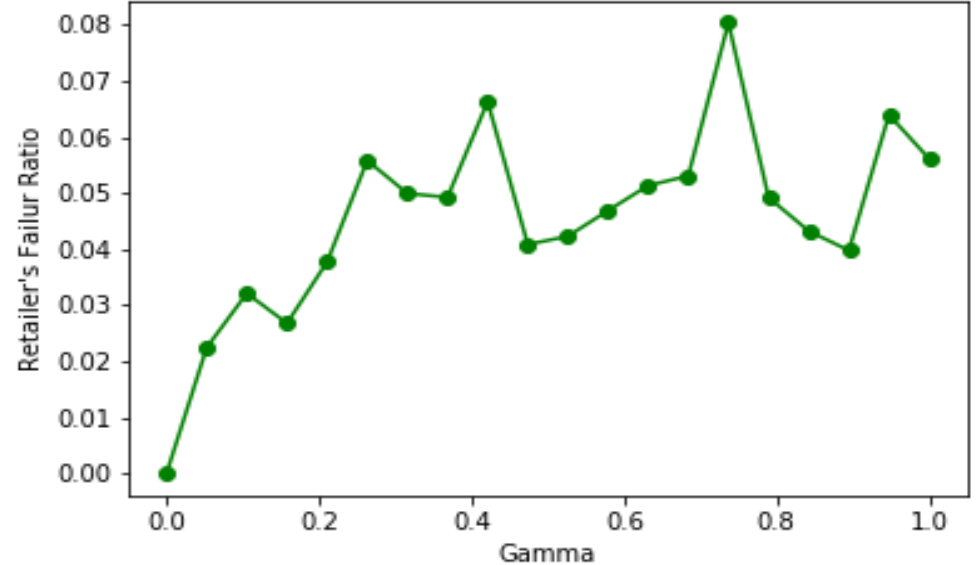
Figure 4. Effect of suspicion weight ( γ ) on retailer’s failure ratio